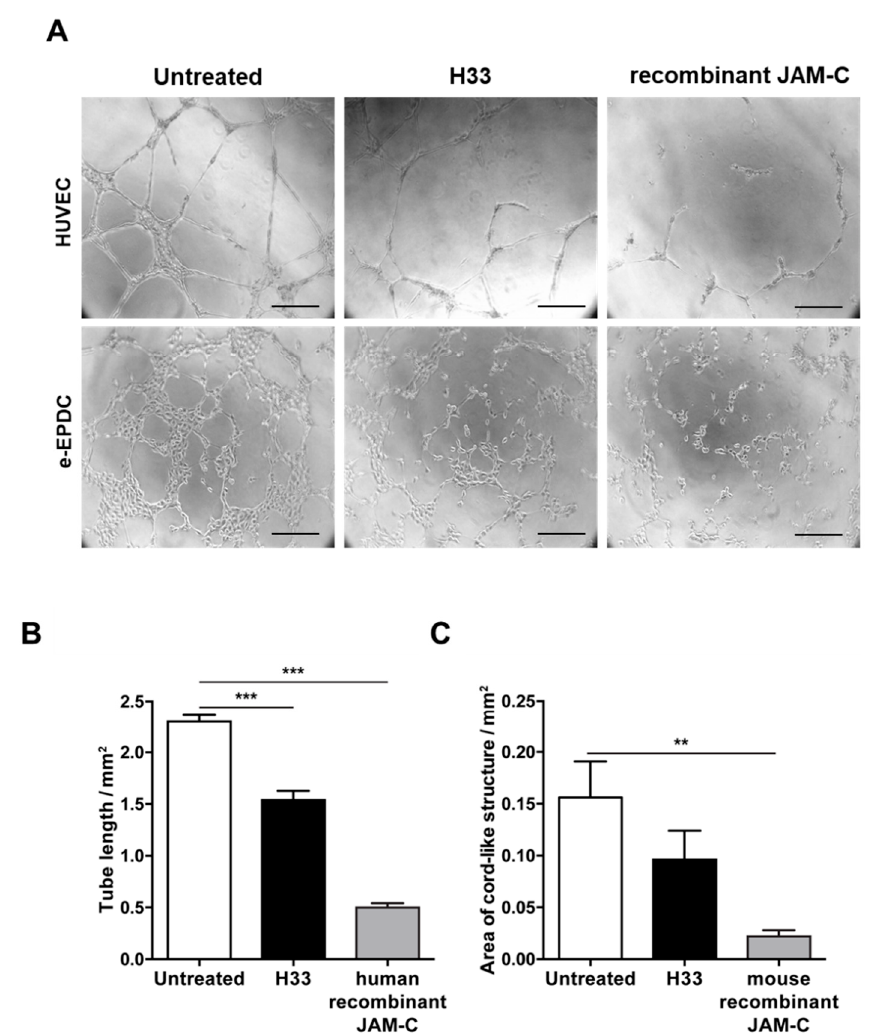
Figure 3. Blocking JAM-C via monoclonal antibody reduces in vitro cord-like structures on Matrigel TM . ( A ) Representative images of HUVEC cord-like structures and embryonic-Endothelial Progenitor-Derived Cells (e-EPDCs) cultured on matrigel for 24 h, untreated, treated with anti-JAM-C antibody H33 or with recombinant (r-JAM-C) human JAM-C or mouse JAM-C are shown. ( B-C ) Total tube length was reported for HUVEC ( B ) and the total area of cord-structures for e-EPDCs ( C ). Data are represented by mean ± SD of three separate experiments (** p < 0.01, *** p < 0.001, compared to control values). Scale bar is 50 μ m.